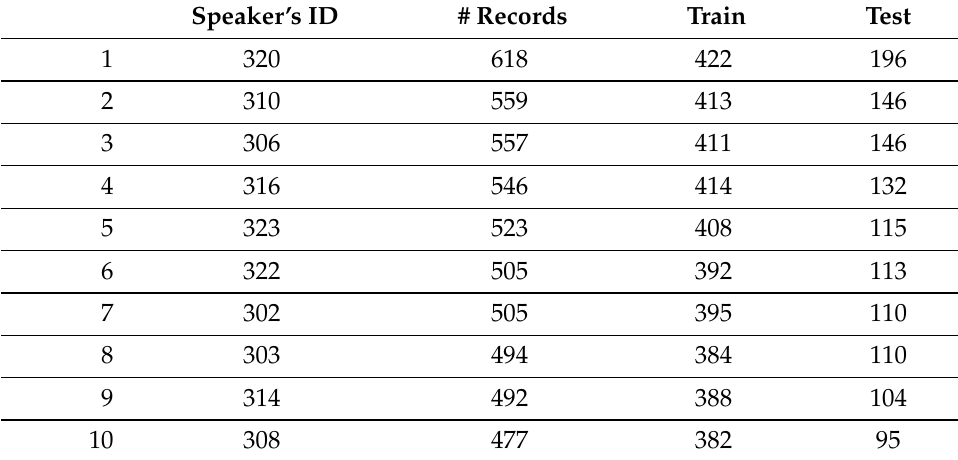
Table 1. Training and test sets speaker by speaker, sorted by the number of records contained in test